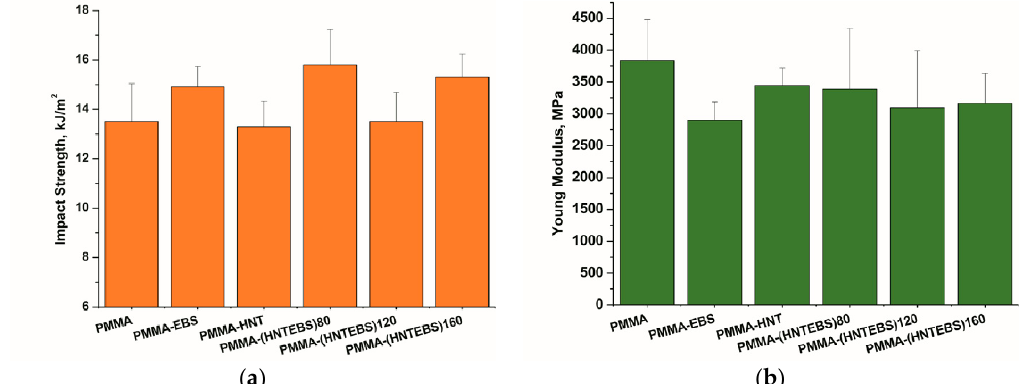
Figure 14. Impact strength ( a ) and Young modulus ( b ) of PMMA/HNT nanocomposites compared to PMMA and PMMA with EBS or